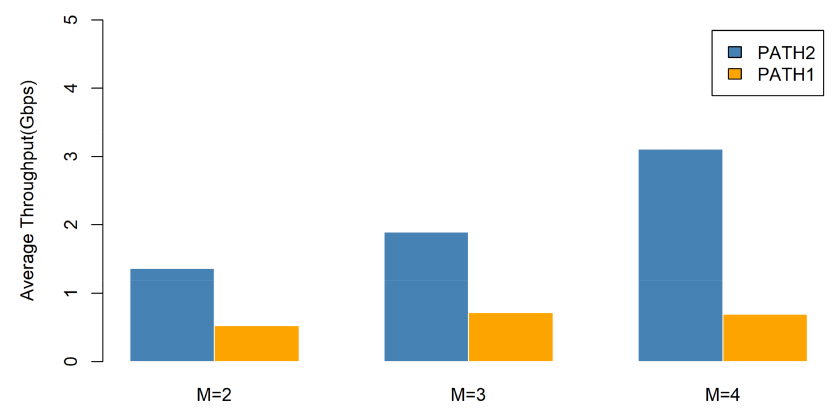
Figure 10. Results of the influence of the number of flow entries.